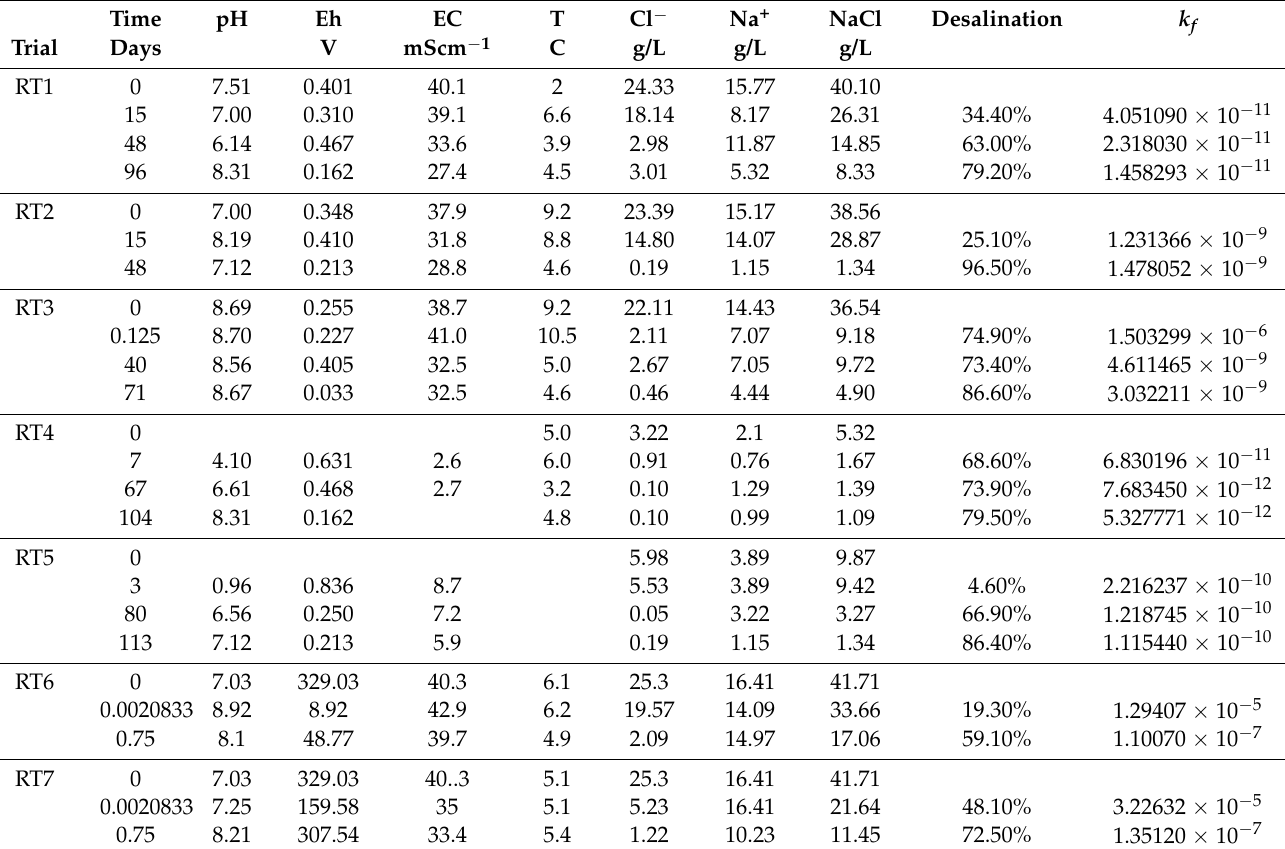
Table A2. Trial results for Trials RT1 to RT7. k f = forward rate constant, g NaCl